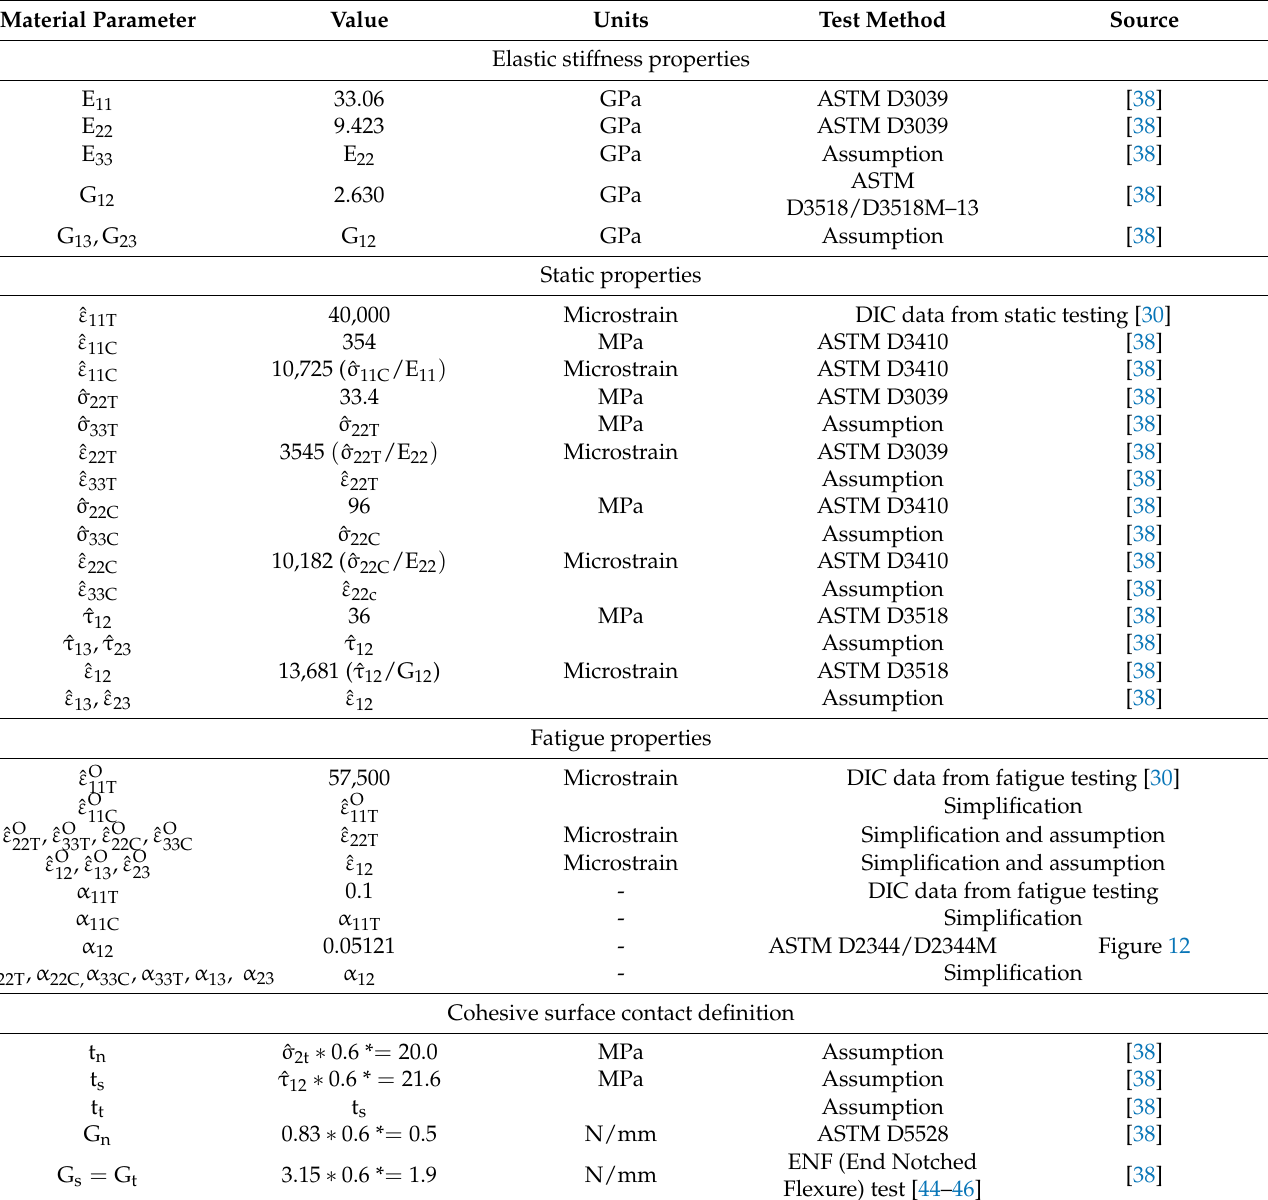
Table 2. Material